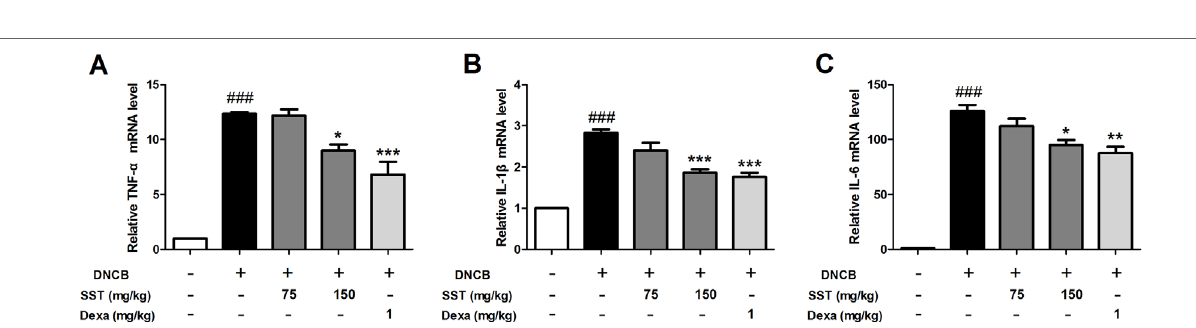
FIGURE 9 | Inhibitory effects of SST on mRNA expression level of inflammatory cytokines in DNCB-induced dorsal skin tissue. The pro-inflammatory cytokine mRNA expression levels of TNF- α (A) , IL-1 β (B) , and IL-6 (C) were analyzed using real-time PCR. The data are shown as mean ± SEM of triplicate experiment. ### p < 0.001 vs. normal group, *p < 0.05, **p < 0.01, or ***p < 0.001 vs. DNCB-induced